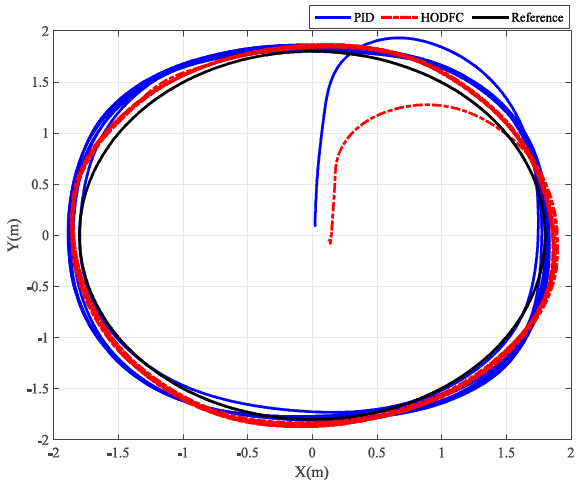
Figure 12. Experimental results of the spatial plane trajectory tracking.